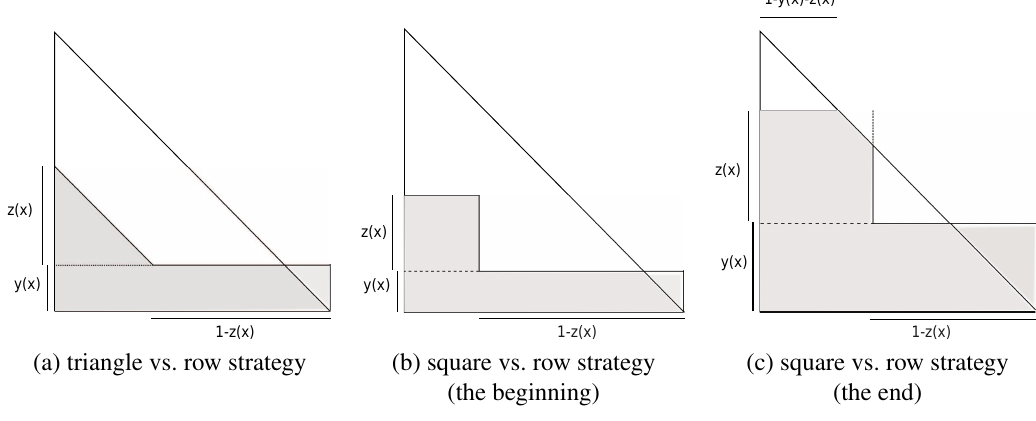
Fig. 2: Two extreme strategies yielding lower and upper